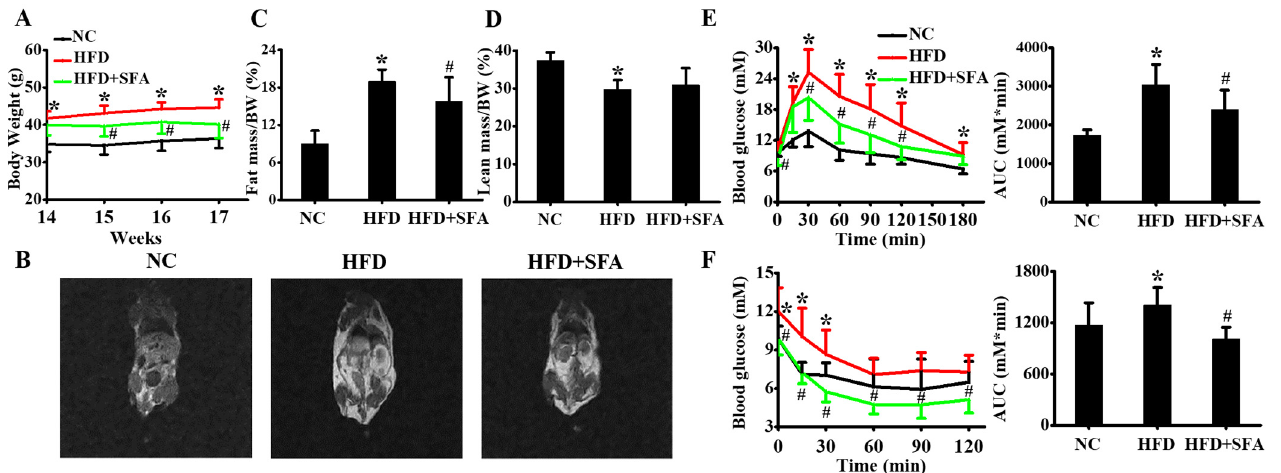
Figure 4. Inhibition effects of SFA on weight gain, fat distribution and insulin resistance in HFD-fed C57BL/6J mice: ( A ) Body weight of mice in three groups from week 14 to week 17 ( n = 8/group); ( B ) MRI images showed fat distribution in mice at week 17 ( n = 6/group). The percentage of fat mass ( C ) and lean mass ( D ) were calculated ( n = 6/group); ( E ) glucose tolerance test and the area under the curve were analyzed at week 17 ( n = 8/group); ( F ) insulin tolerance test and the area under the curve were analyzed at week 17 ( n = 8/group). All values are expressed as means ± SD, * p < 0.05 vs. NC group; # p < 0.05 vs. HFD group. NC, normal chow; HFD, high-fat diet; AUC, area under the curve.